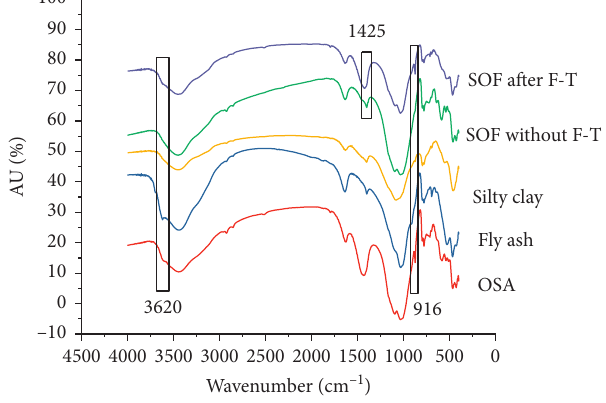
Figure 11: FTIR analysis for test soils. Table 5: Mineral composition of raw materials and